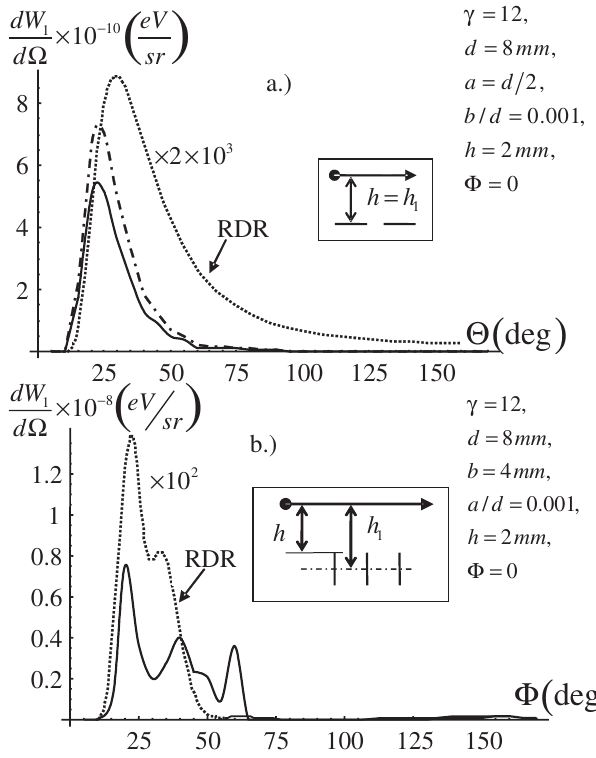
FIG. 8. Angular distribution of the SPR intensity for a grating with vacuum gaps according to van den Berg’s model (a solid line—in region I ; a dash-dotted line—in region III ): (a) volume grating ( a (cid:5) b (cid:5) d= 2 ); (b) flat grating ( b=d (cid:5) 0 : 01